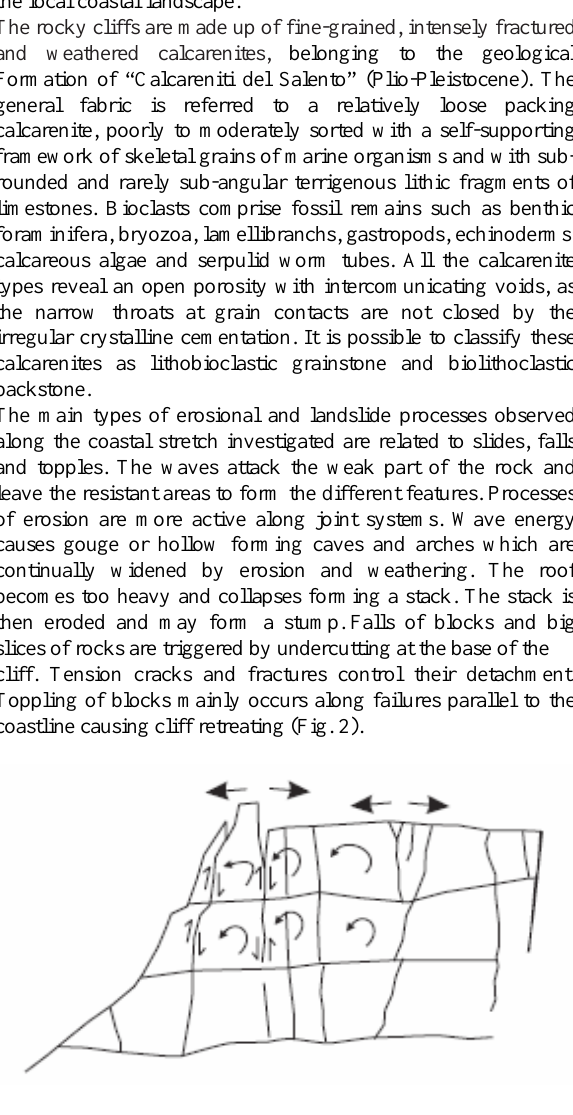
Figure 2. Toppling failure mechanism (after Hoek et al.,